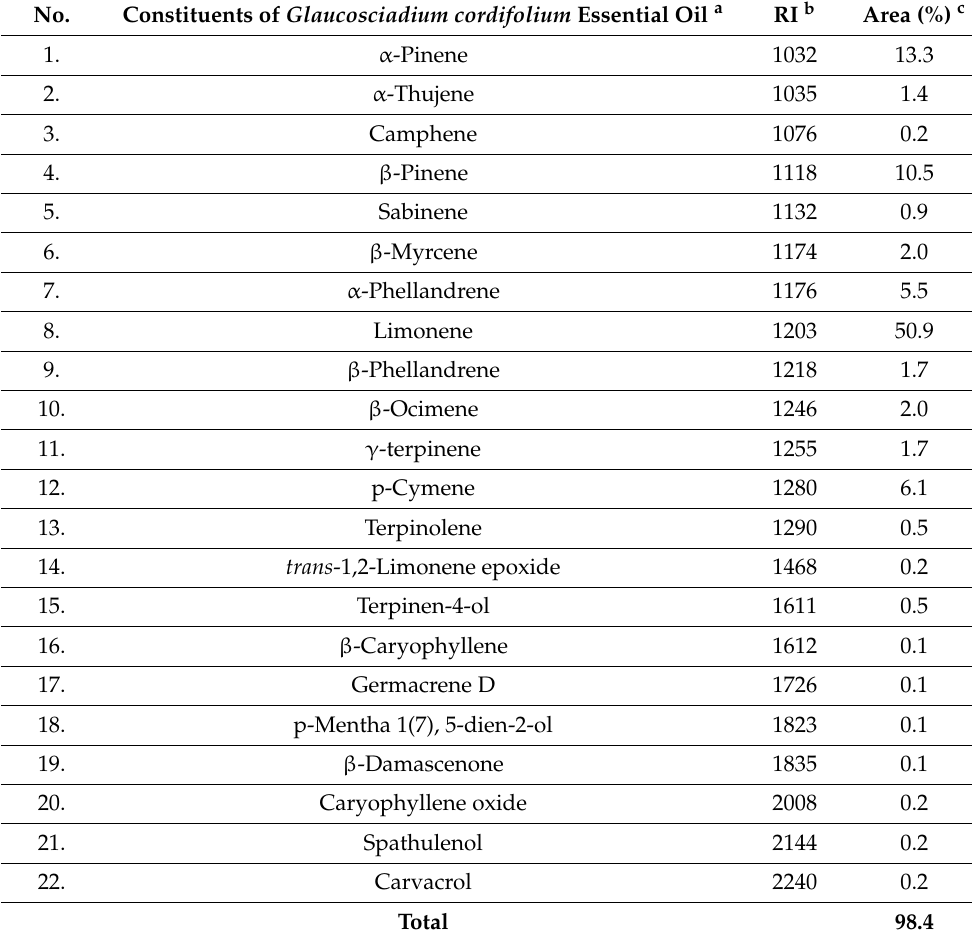
Table 1. The composition of Glaucosciadium cordifolium essential oil determined by GC-MS